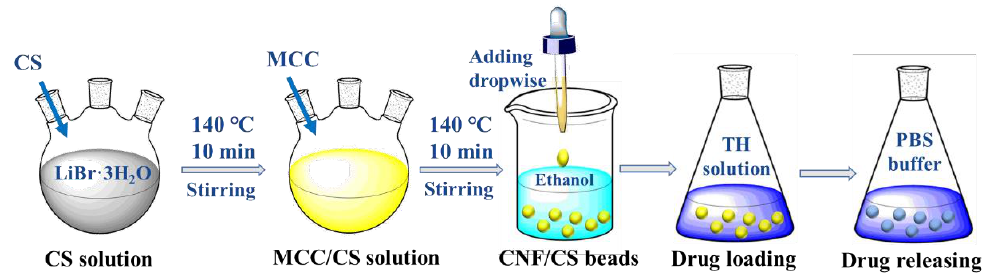
Figure 1. The technical route of this work.